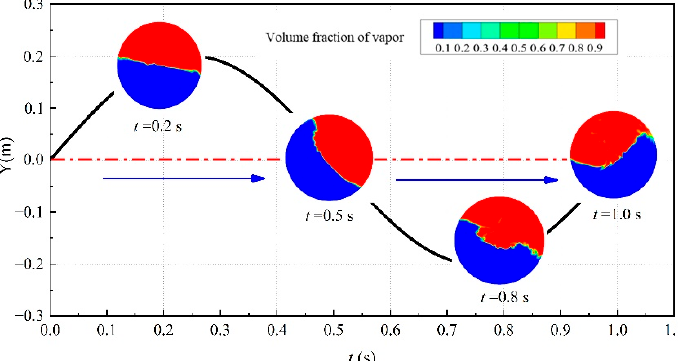
Figure 6. Interfacial behavior at various times in a period (LR = 50%).